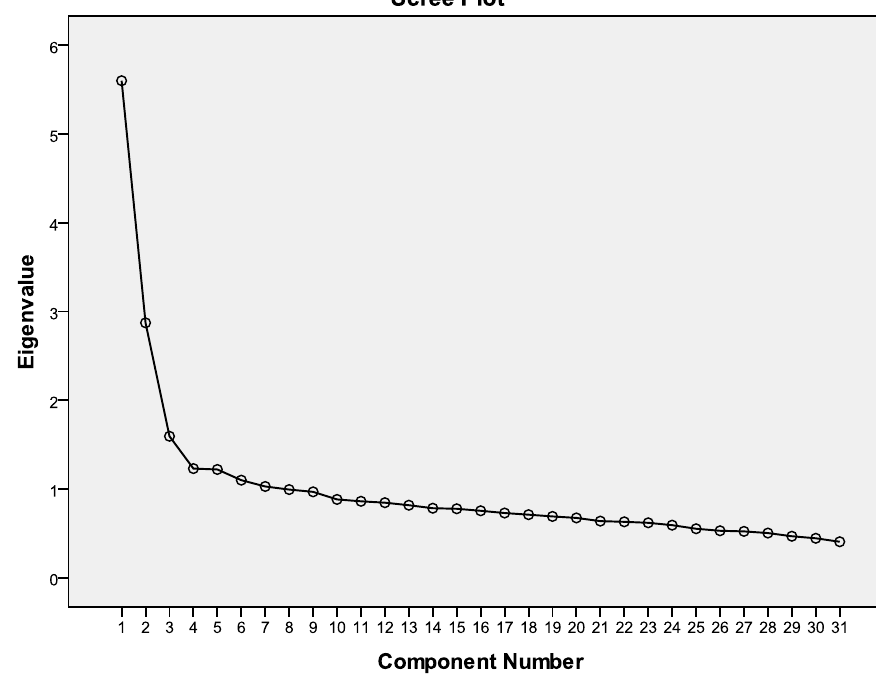
Figure 1. Scree plot from the results of factor analysis for the ALAS.